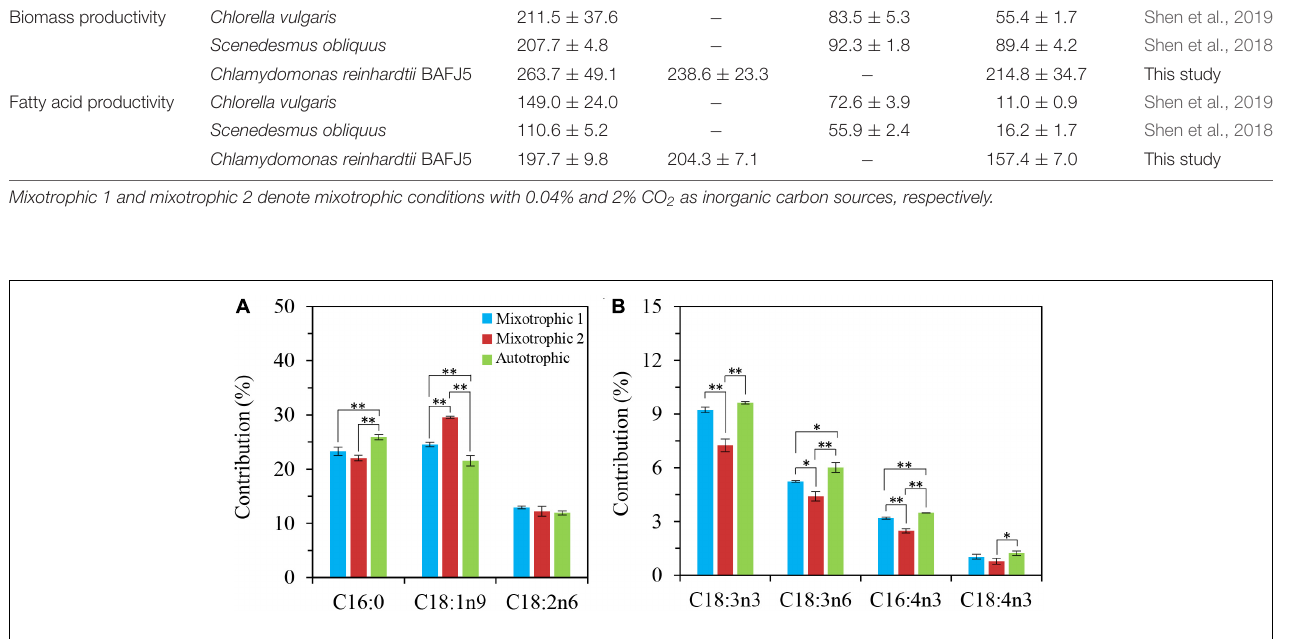
TABLE 2 | Biomass and fatty acid productivities in nitrogen-deprived green algae under distinct carbon supply regimes.